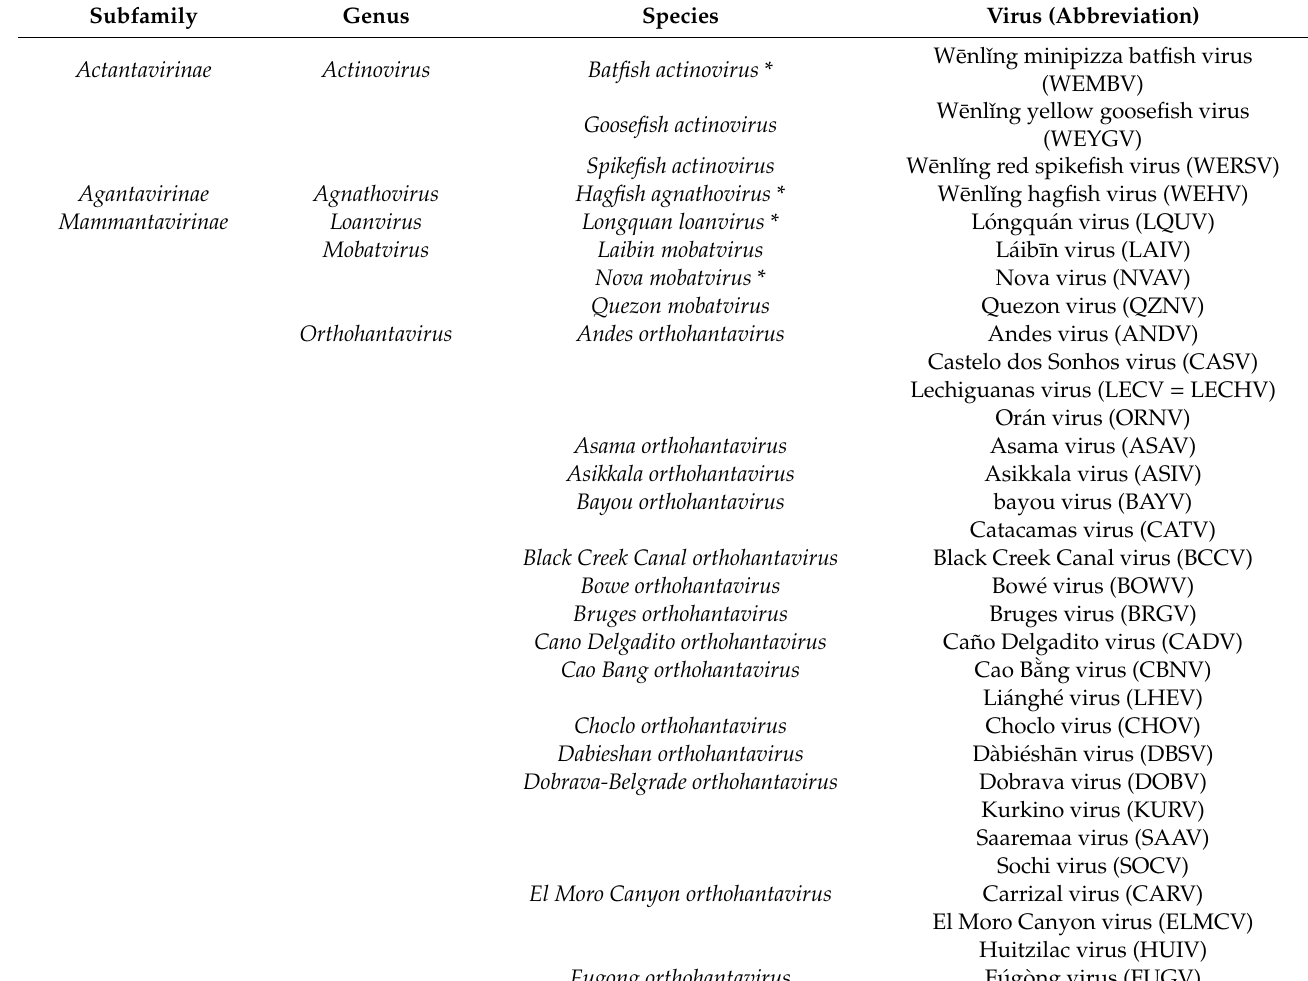
Table 5. Classification of hantavirids in 2019